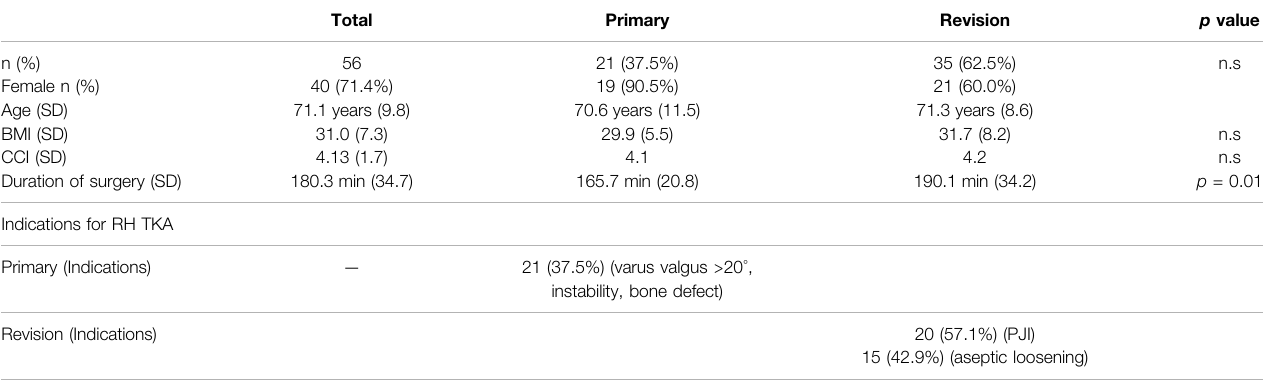
TABLE 1 | Patient demographic data strati fi ed by primary and